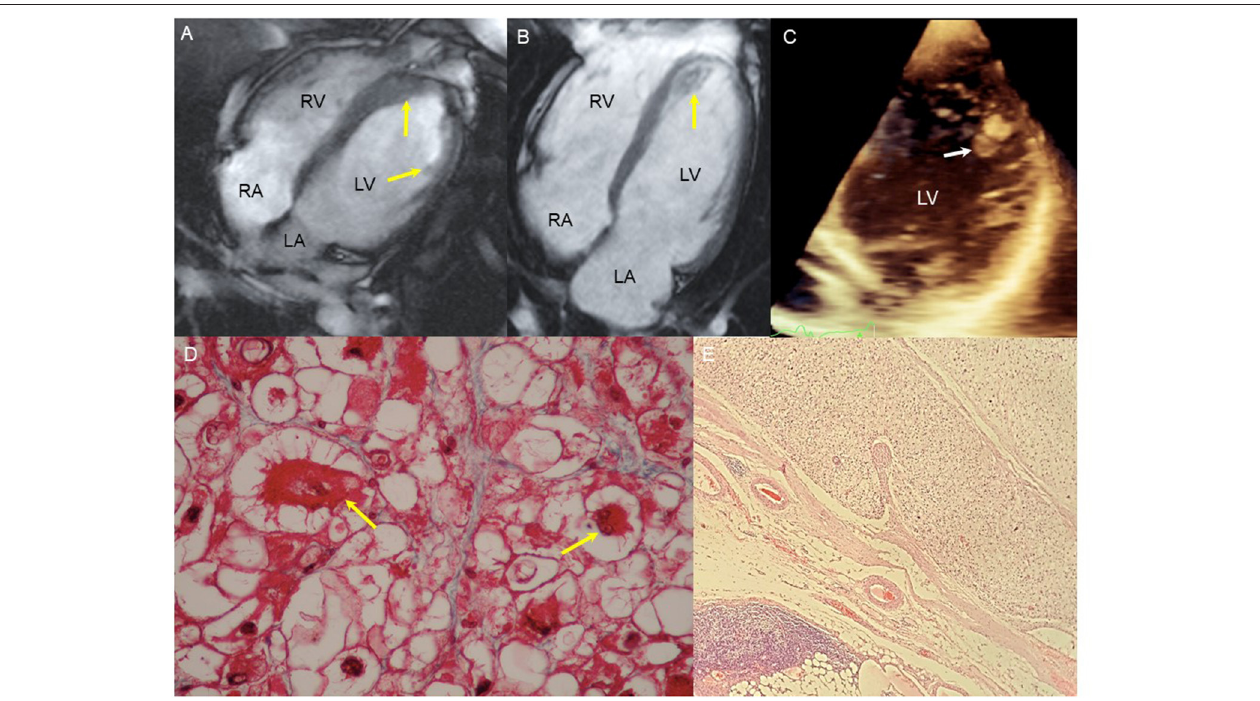
FIGURE 1 | Image and tissue findings. (A) CMR 4 chamber image revealing an 8 × 6mm mass in the lateral LV wall on the papillary muscle insertion and septal thickening (arrows). (B) CMR 4 chambers, 36 × 35mm mass with diffuse enhancement occupying the totality of the LV apex (arrow). (C) Four-chamber echocardiogram, 8-mm hyperechoic, homogeneous, rounded mass on the lateral wall of the LV (arrow). (D) Micrograph of the first heart tumor. Some nuclear atypia can be seen and two “spider” cells (yellow arrows). Masson trichomic. 40 × . (E) Micrograph of lymph node with tumoral cells in an alveolar pattern. On the lower left side of the image, the residual lymphatic tissue can be seen. H/E. 4 ×